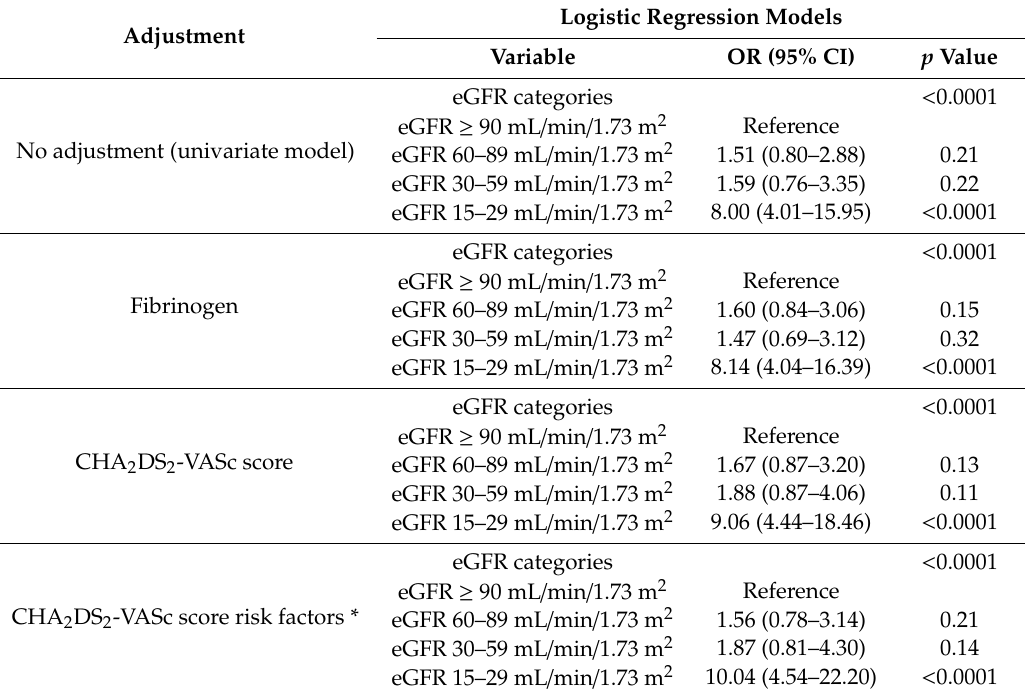
Table 3. Estimated glomerular filtration rate categories as predictors of high endogenous thrombin potential (the top quartile, ≥ 1682.3 nM × min, n = 125).